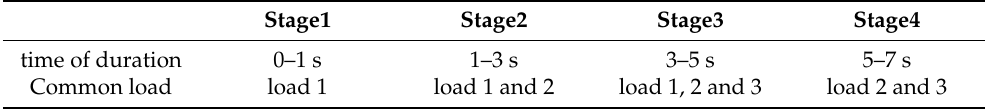
Table 4. Connected common